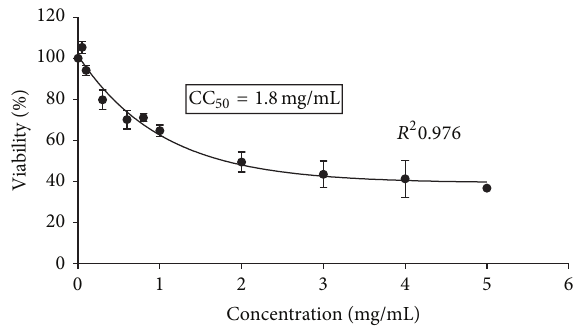
Figure 2: Percentage of viability of cultured Vero cells, incubated for 48h in the presence of A. aroma hot aqueous extract at different concentrationsdeterminedbyneutralreduptake(NRU).Eachpoint representsthemeanoffourindependenttrials.CC 50 was1.8 mg/mL.